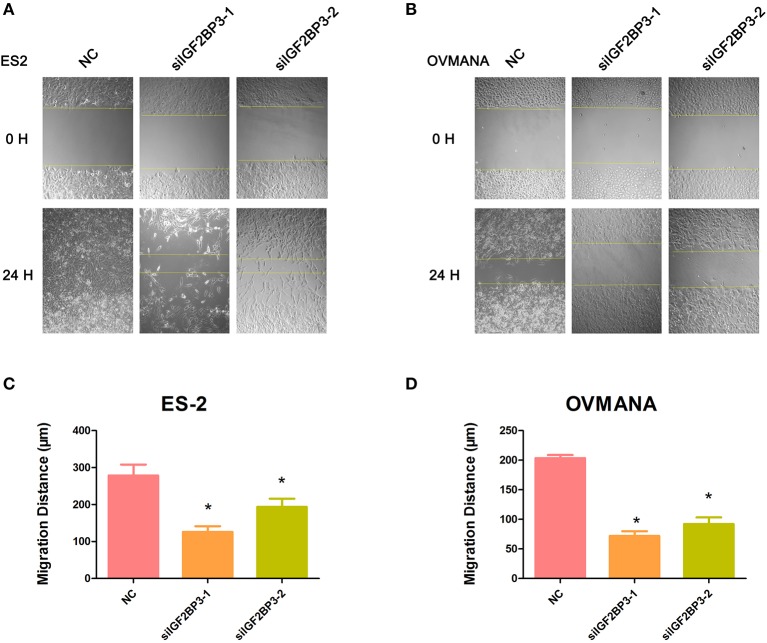
Effects of siIGF2BP3 on OCCC cell migration. (A,B) ES2 and OVMANA cells were scratched and treated with NC, siIGF2BP3-1, or siIGF2BP3-2. Photomicrographs were taken at 0 and 24 h after scratching. (C,D) Quantitation of wound healing assay by NC, siIGF2BP3-1, or siIGF2BP3-2, respectively. The migrated distance of cells was determined by measuring the wound width at 24 h and subtracting it from the wound width at 0 h. Results were obtained from three independent experiments, *P < 0.05, compared with NC.